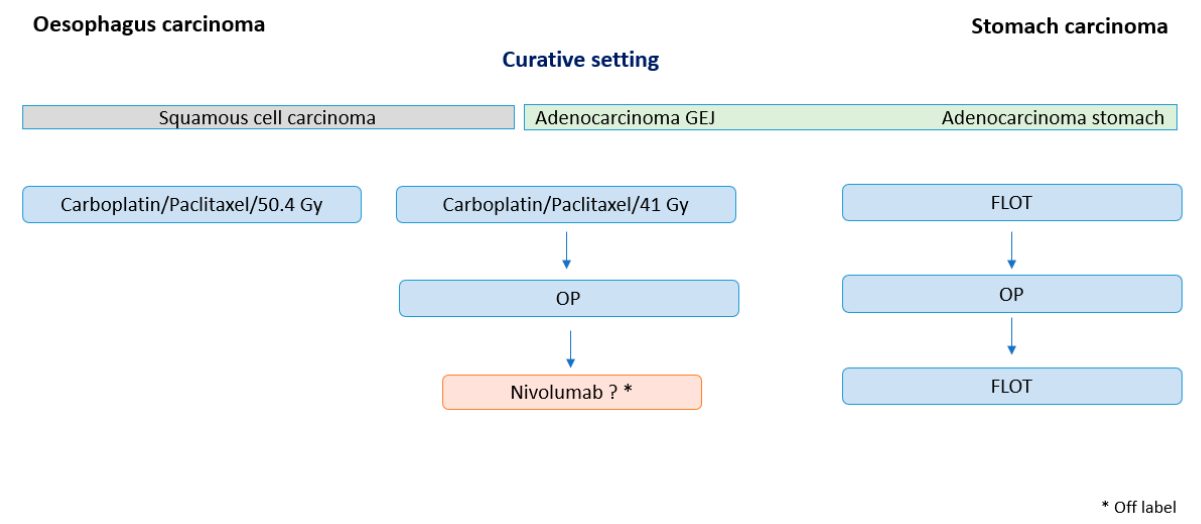
Figure 2. Overview of curative therapy regimes of oesophageal and gastric cancer.